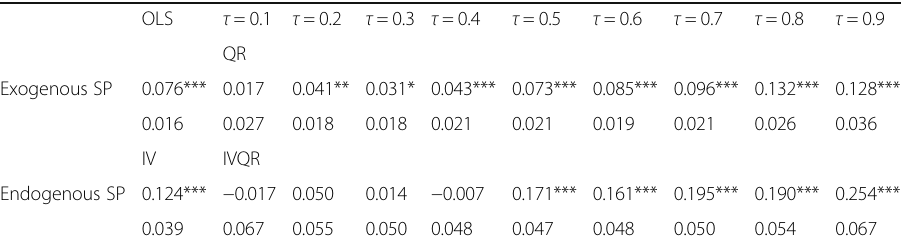
Table 4 IV and IVQR estimates — no occupation